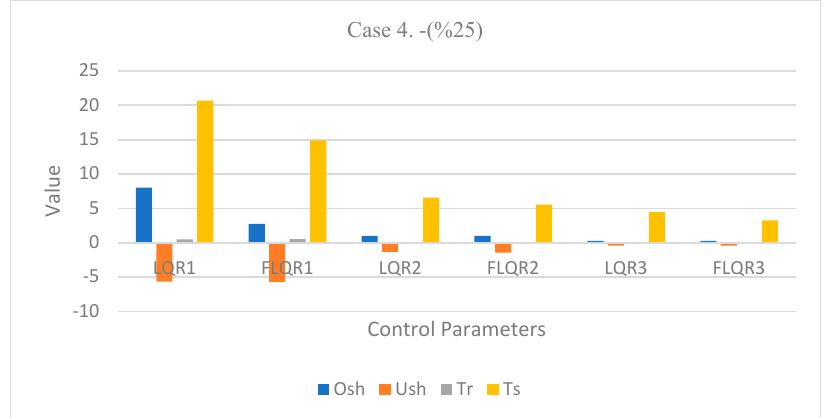
Figure 14. Case 4 comparison.